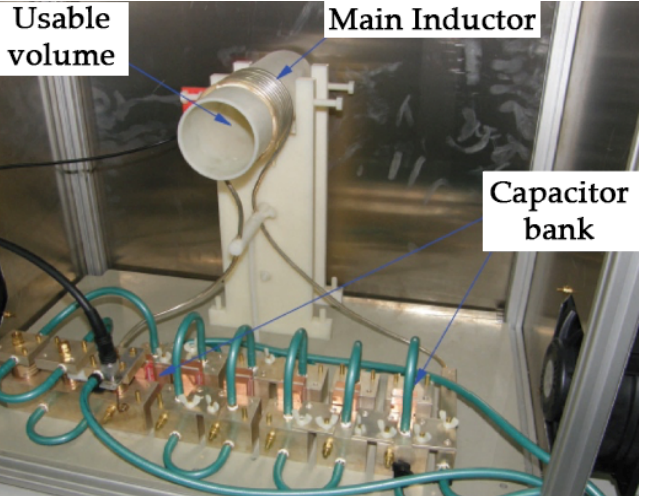
Figure 1. Alternating magnetic field (AMF) inductor. The picture shows its main components.